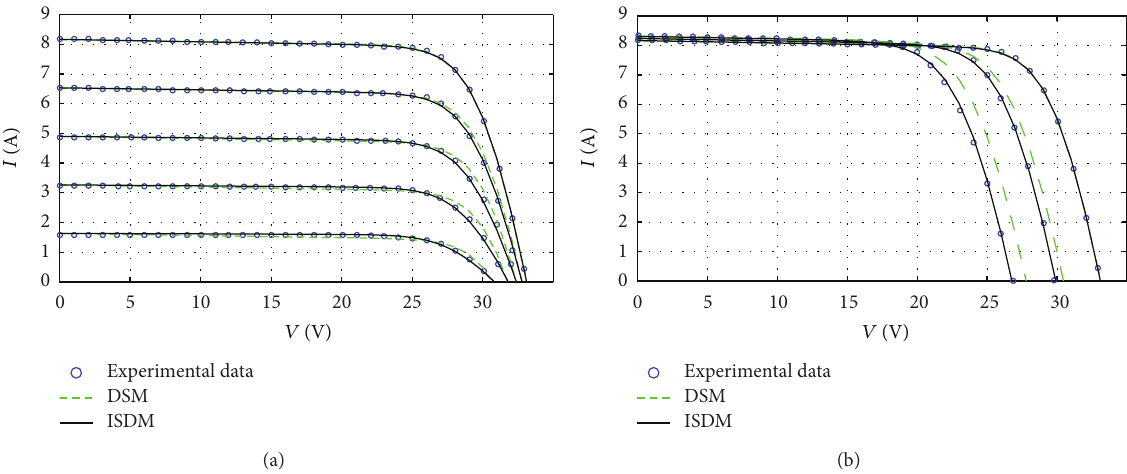
Figure 3: The simulated 𝐼 - 𝑉 characteristic curves of the KC200GT PV module: (a) under different irradiance levels; (b) under different temperature levels.